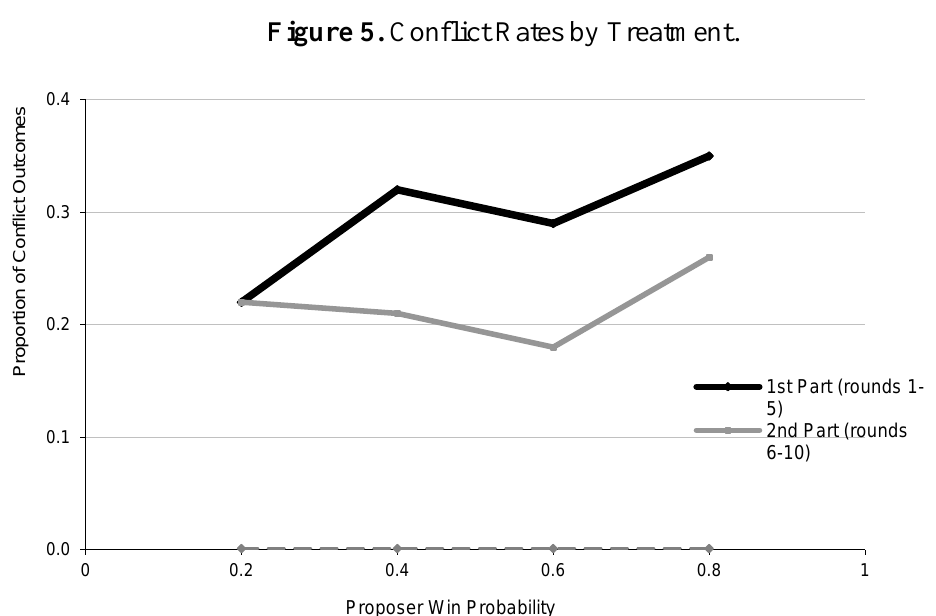
Figure 5. Conflict Rates by